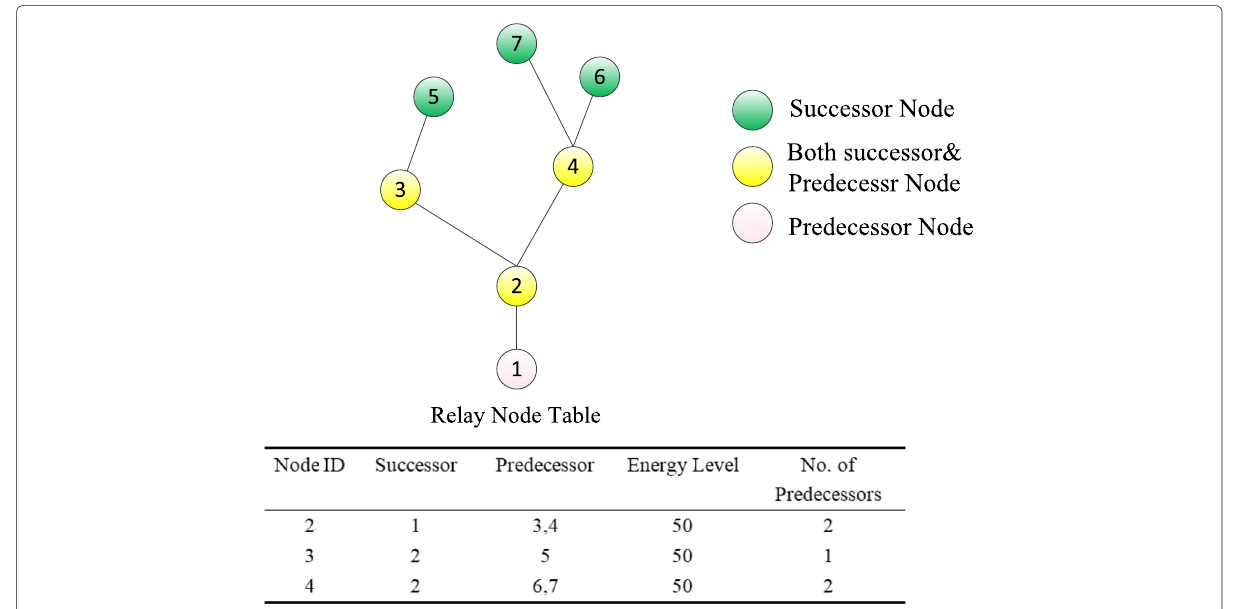
Fig. 4 Predecessor and successor with an exemplary relay node table. This is a routing tree, the vertex is the sensor node, the edge is the link between the nodes. The table below shows information about relay